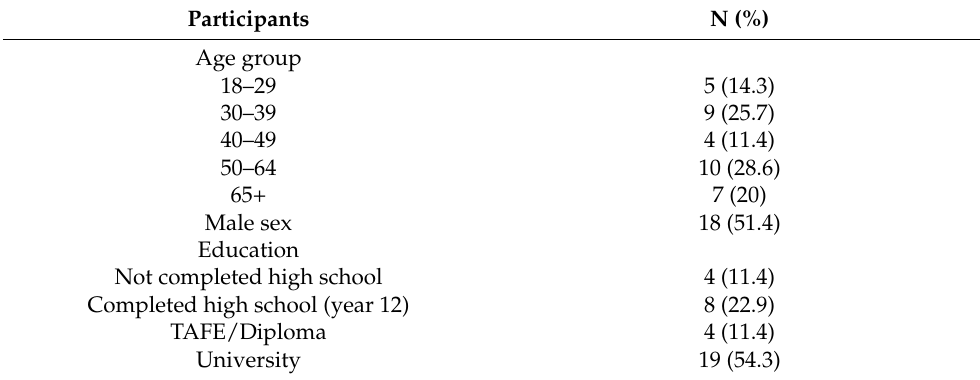
Table 1. Demographics of the 35 participants included in the analysis.